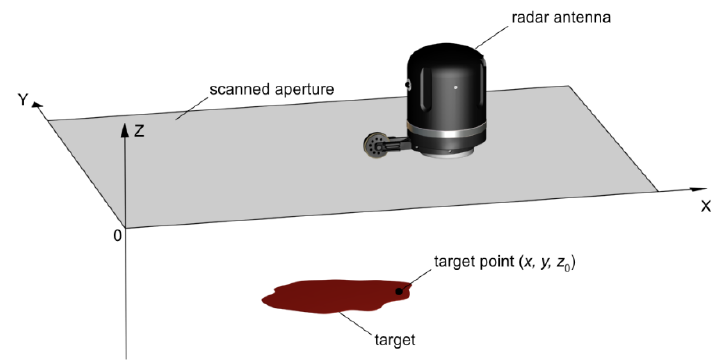
Figure 11. Geometry of a holographic imaging system.